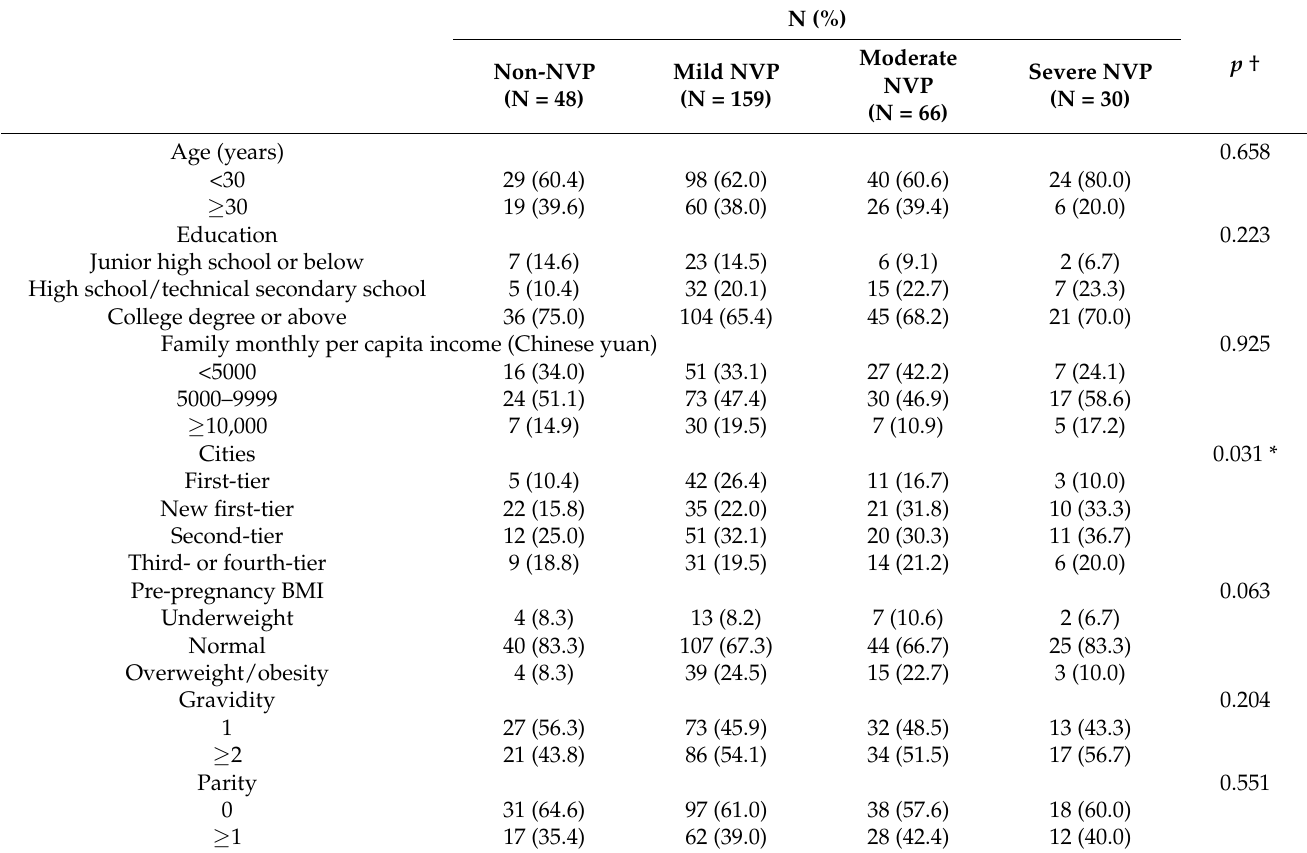
Table 1. Incidence and demographic characteristics of nausea and vomiting during early pregnancy.